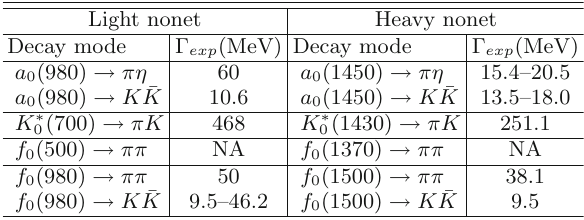
Table 3 Partial decay modes and the corresponding widths collected from PDG [1] are listed here for the light and heavy nonets. The partial widths from f 0 ( 500 ) , f 0 ( 1370 ) are not available (NA) at the moment due to the lack of experimental data. Since our purpose is to compare the common decay modes in the two nonets, the other decay modes